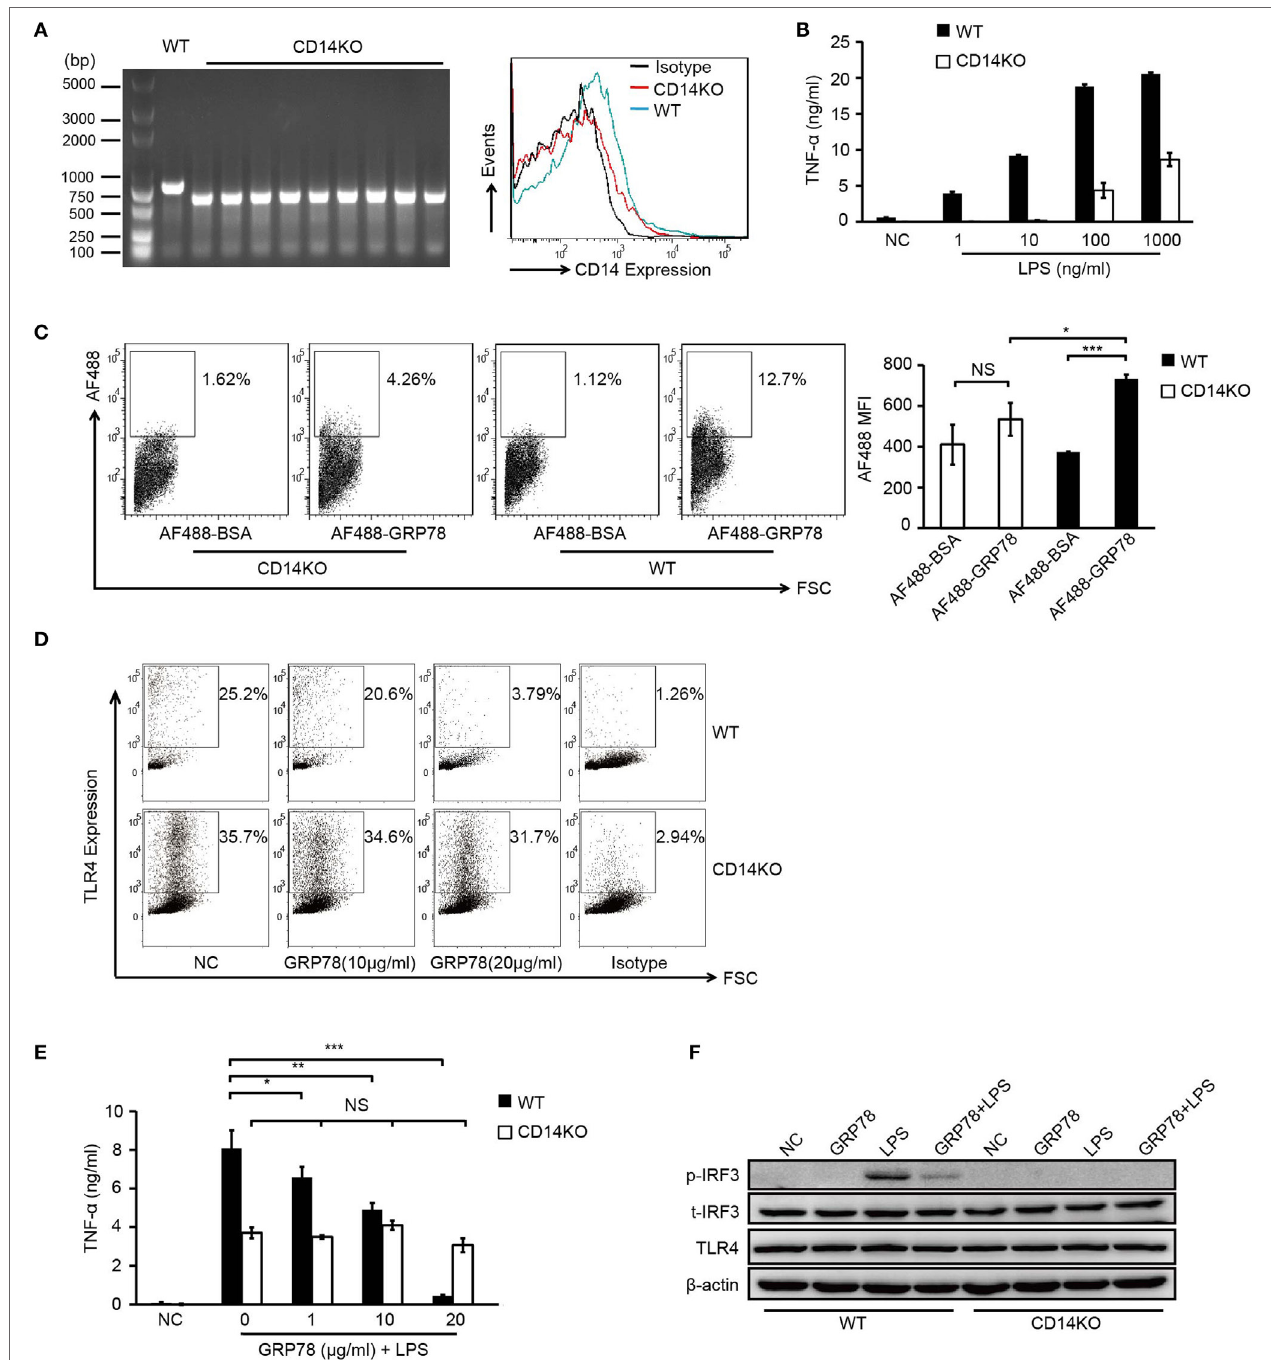
FigUre 5 | grP78-induced Tlr4 endocytosis is cD14 dependent . (a) CD14 levels on WT and CD14KO bone marrow-derived dendritic cells (BMDCs) were determined by PCR (left) and FCM (right). PCR products of CD14 gene in the genomic DNA from WT and CD14KO mouse: CD14 knockout = ~600 bp, wild type = 840 bp (according to the Jackson Laboratory). (B) Enzyme-linked immunosorbent assay (ELISA) of TNF- α in WT or CD14KO BMDCs stimulated for 4 h by LPS at the concentrations indicated. (c) FCM analyses for GRP78 binding with WT or CD14KO BMDCs. Representative dot plots (left) and MFI (right) are shown. (D) WT or CD14KO BMDCs were treated with 10 µg/mL or 20 µg/mL GRP78 for 30 min. Surface TLR4 was determined by FCM. (e) ELISA of TNF- α in WT or CD14KO BMDCs treated with LPS (100 ng/mL) and GRP78 for 4 h. (F) WT or CD14KO BMDCs were stimulated with GRP78 (20 µg/mL), LPS (100 ng/mL), or mixtures of GRP78 and LPS at 37°C for 30 min, cells were lysed, and phoepho-IRF3, total-IFR3, TLR4, and actin were detected by immunoblotting. Error bars represent mean ± SD from triplicate samples in one experiment. NS, not significant; * P < 0.05, ** P < 0.01, and *** P < 0.001.